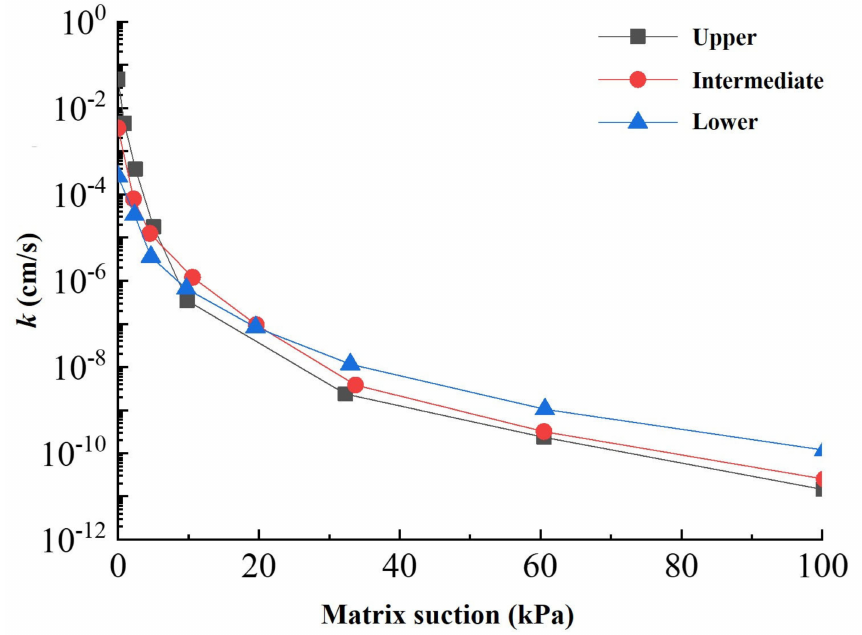
Figure 4. Unsaturated hydraulic conductivity of MSW in this